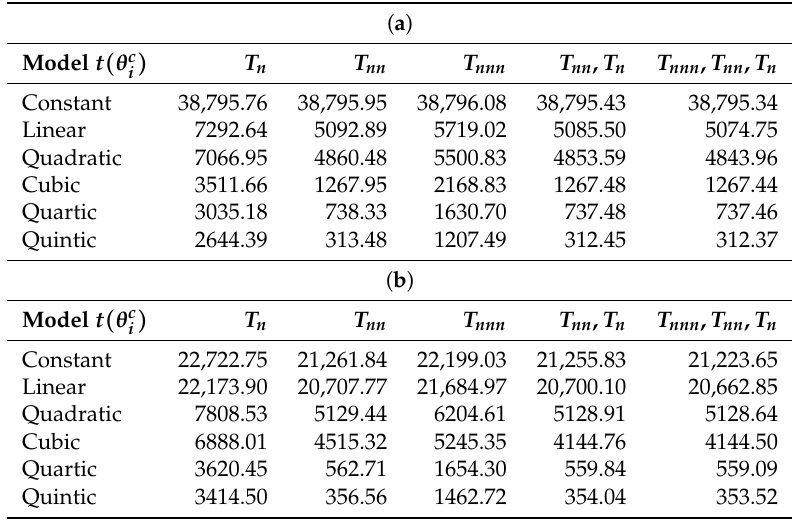
Table 2. Cost function residuals for the different T c models: ( a ) T c x , and ( b ) T c y .